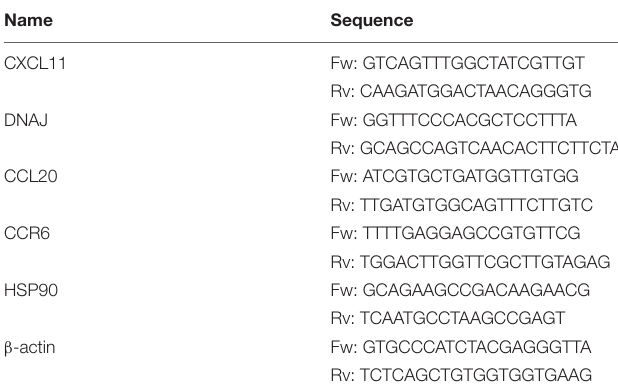
TABLE 1 | Primers used for qPCR verification of the differently expressed